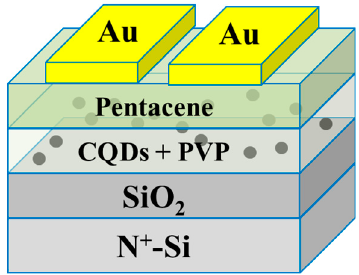
Figure 1. Schematic of the device structure.